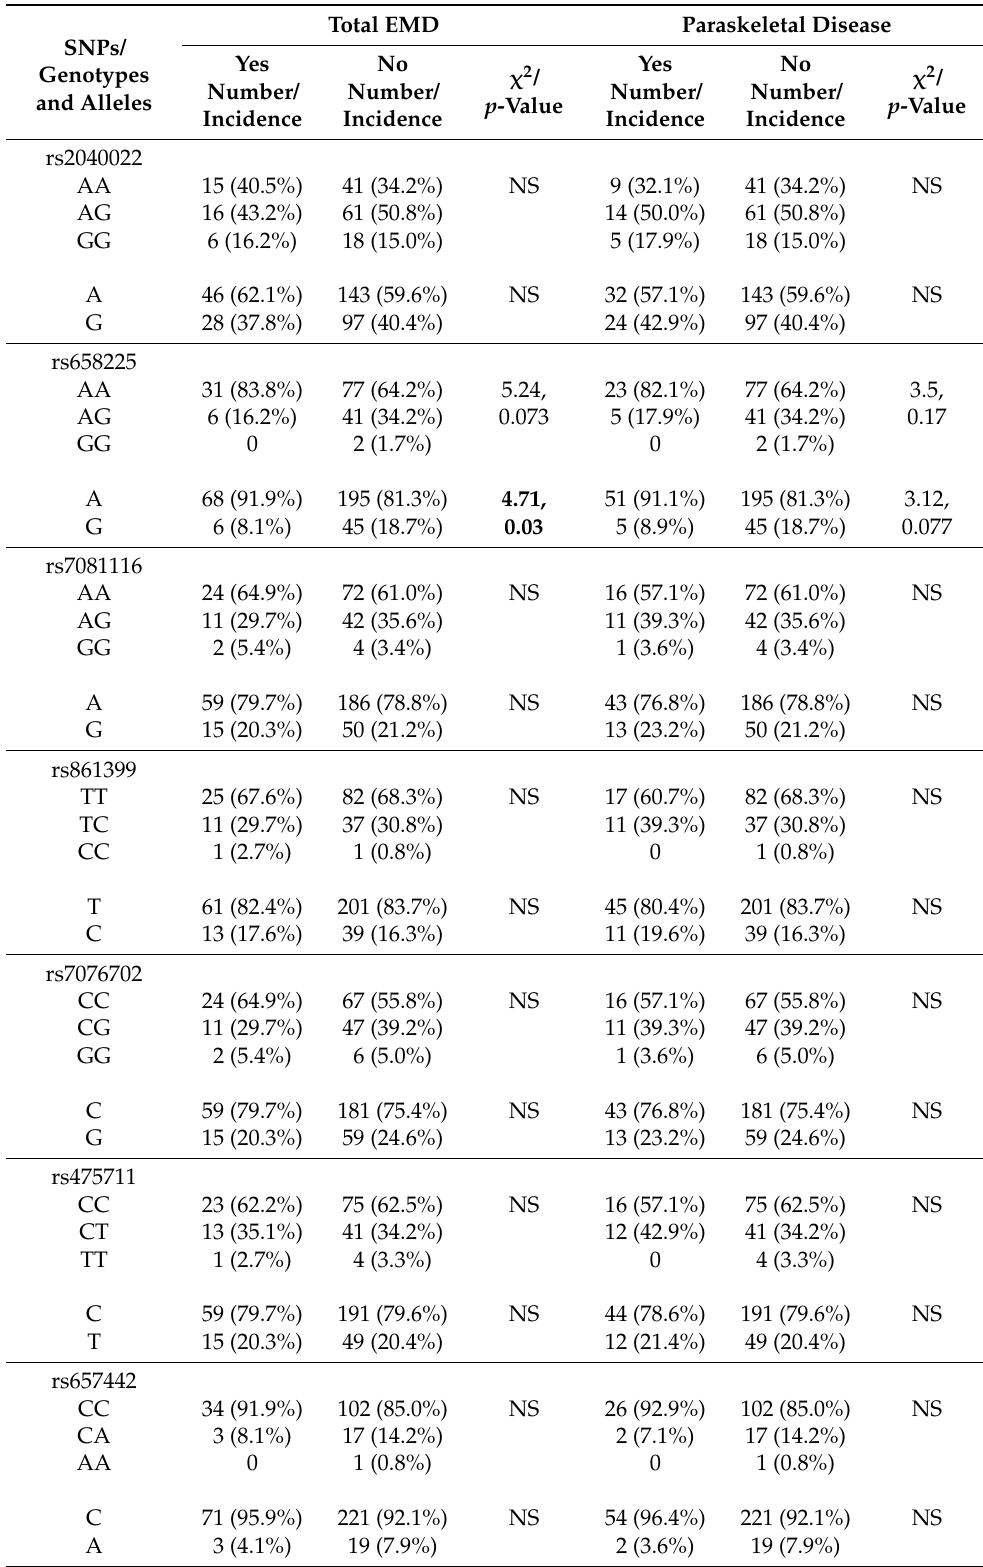
Table 6. Genotype and allele frequencies of the HPSE2 gene SNPs in correlation with secondary extramedullary disease (EMD) in multiple myeloma.